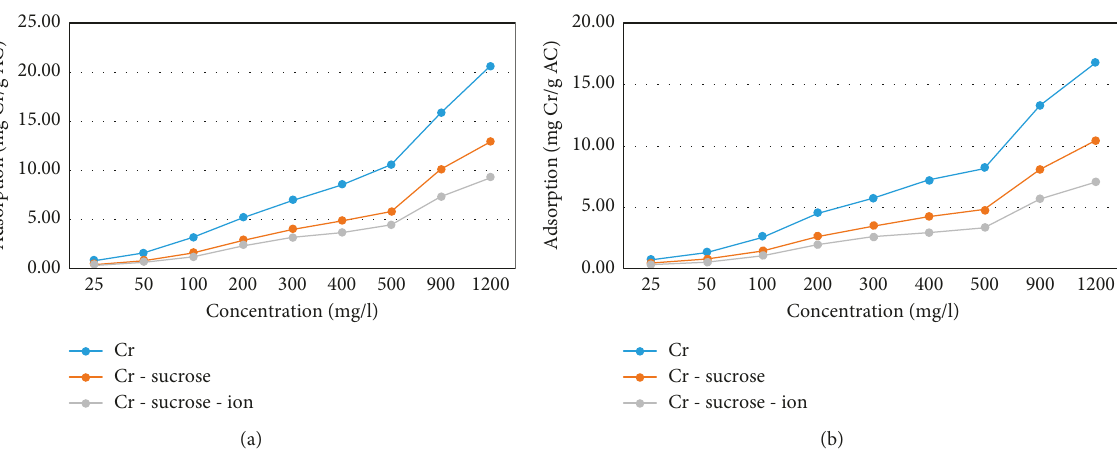
Figure 8: Adsorption behavior of heavy metal ions in the presence of sucrose and various inorganic ions. (a) PAC, pH: 2, T : 298K (b) CAC, pH: 2, T : 298